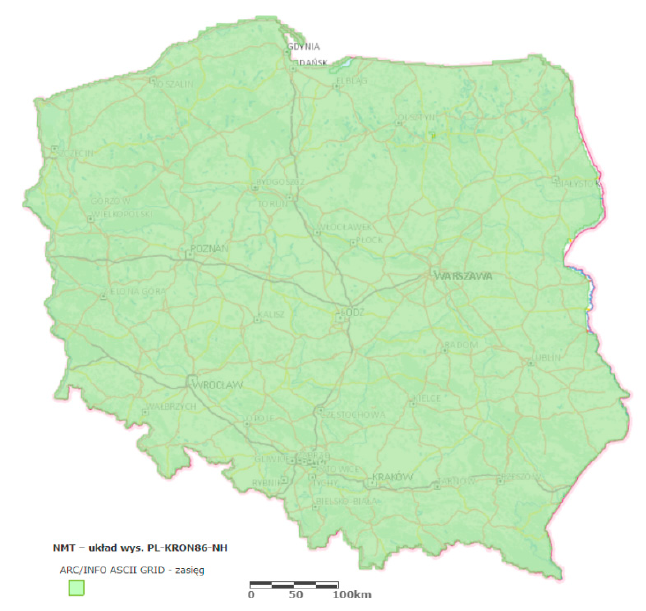
Figure 5. The spatial coverage of tiles available for download in Polish DEM. Source: Polish DEM— Geoportal [57].